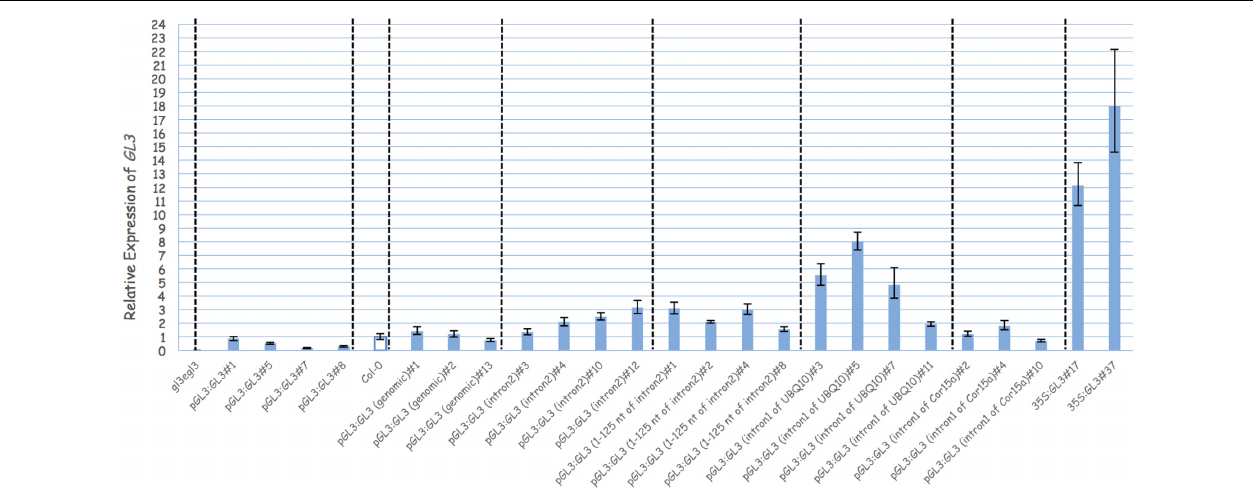
FIGURE 3 | Analysis the function of the second intron of GL3. Relative expression of GL3 in different genotypes. Transcript levels were measured by quantitative real-time PCR and the expression was normalized with reference to the expression of Arabidopsis Actin2 gene. Error bars are the standard deviations of three technical